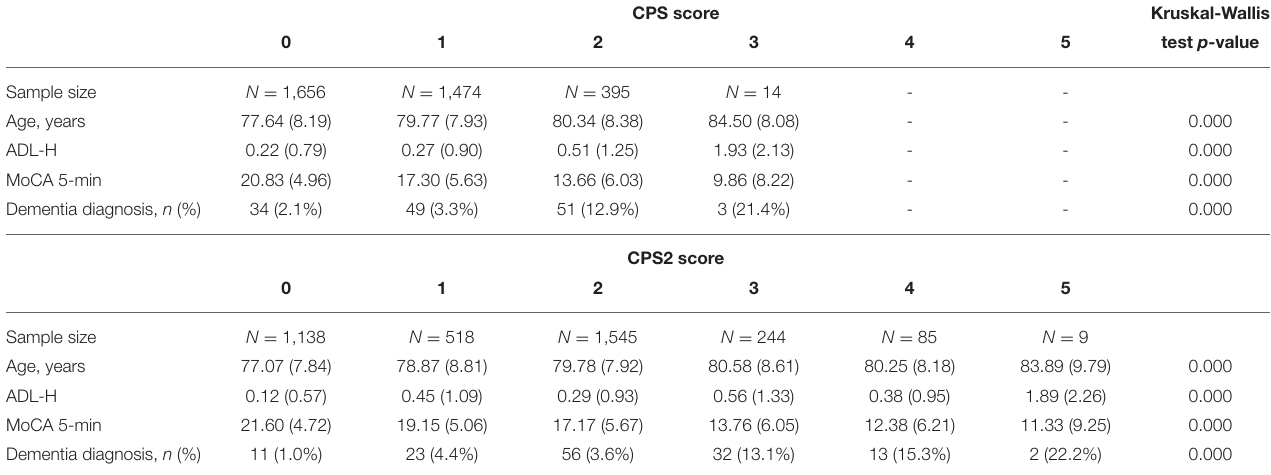
TABLE 2 | Age, functional assessment scores, MoCA 5-min scores, and dementia diagnosis by level of the CPS and